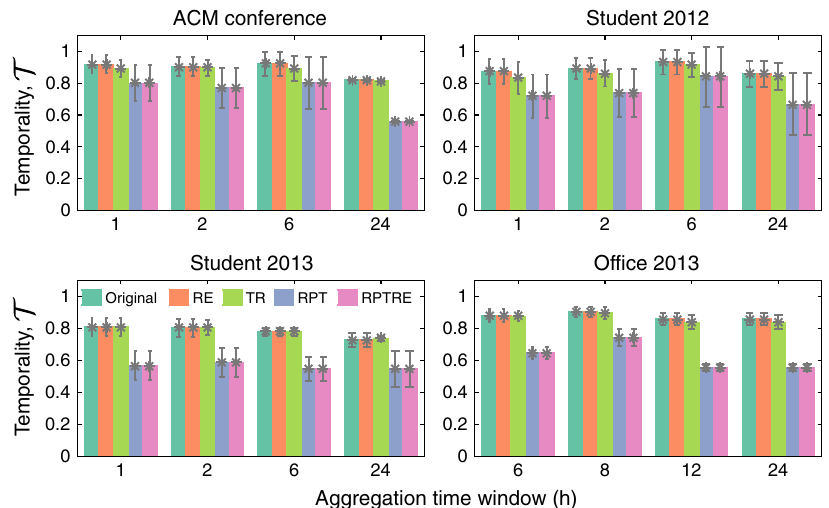
Fig. 5 The temporality of real networks. The temporality T of the original datasets is shown alongside their randomisations for different time windows Δ t . By destroying burstiness, randomisations altering the time ordering of contacts (RPT, RPTRE) decrease T . Supplementary Fig. 15 shows how the overall temporality T arises on a snapshot-by-snapshot basis, and the corresponding standard deviation is given in this fi gure as the error